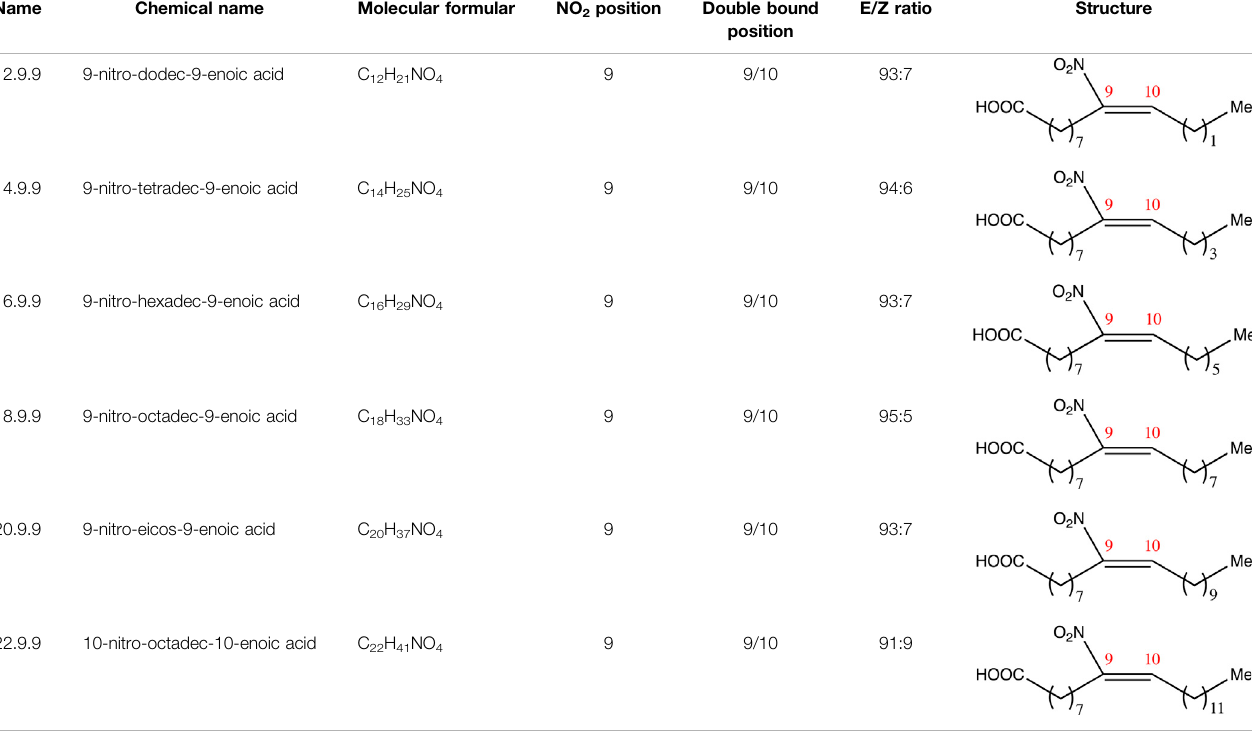
TABLE 2 | Chemical compounds distinguished based on their numbers of carbon atoms derived from the chemical lead